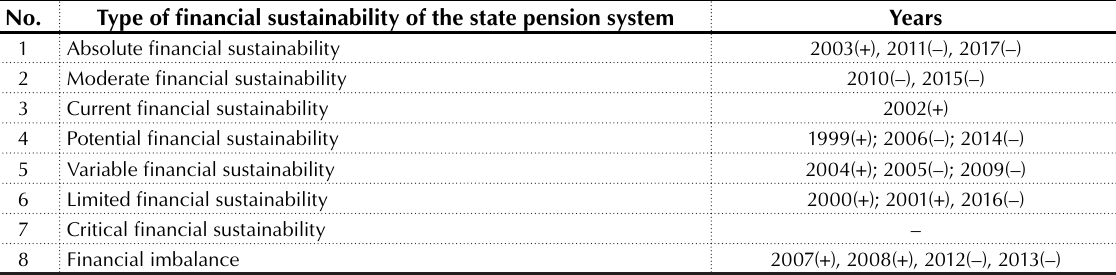
Table 7. Identification of financial sustainability of the Ukrainian pension system for